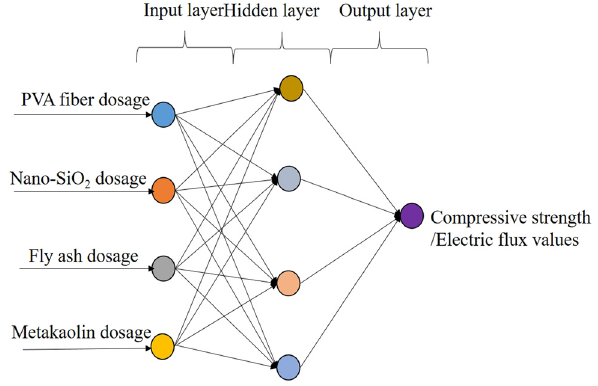
Figure 2: Structure of RBF neural network.